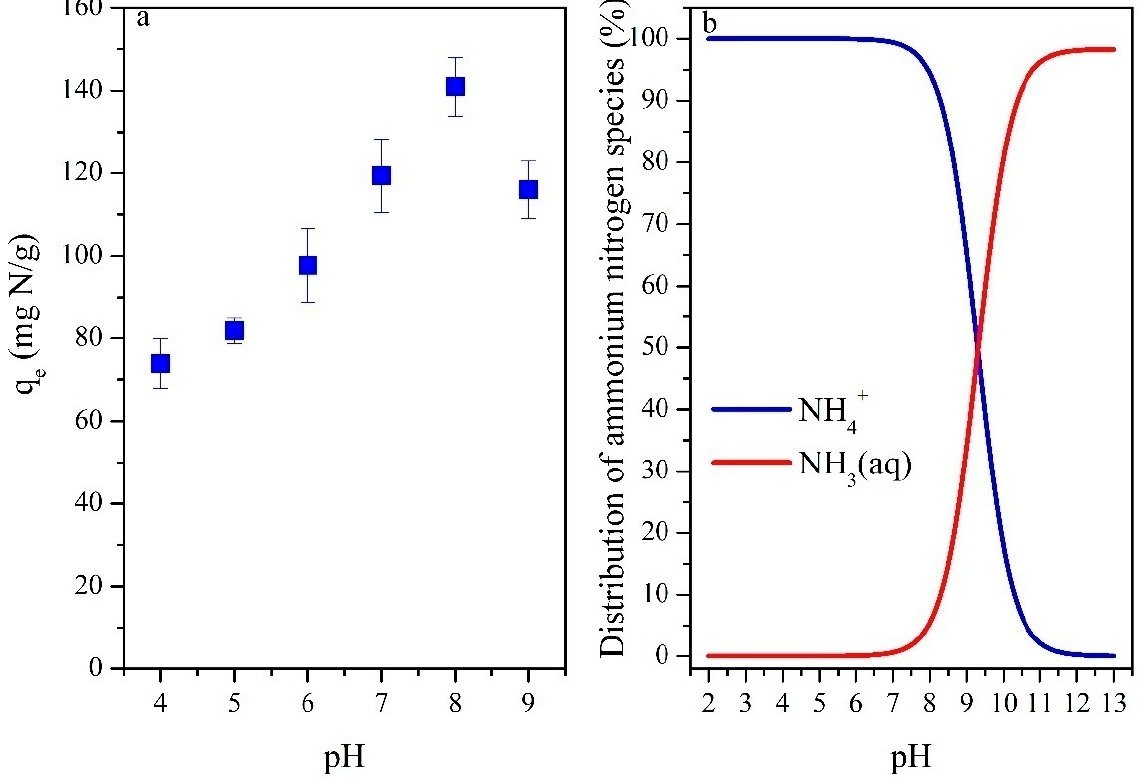
Figure 4. ( a ) Impact of pH on NH 4+ -N removal efficiency from liquid by using M-Zeo as adsorbent; ( b ) distribution of ammonium species in liquid.